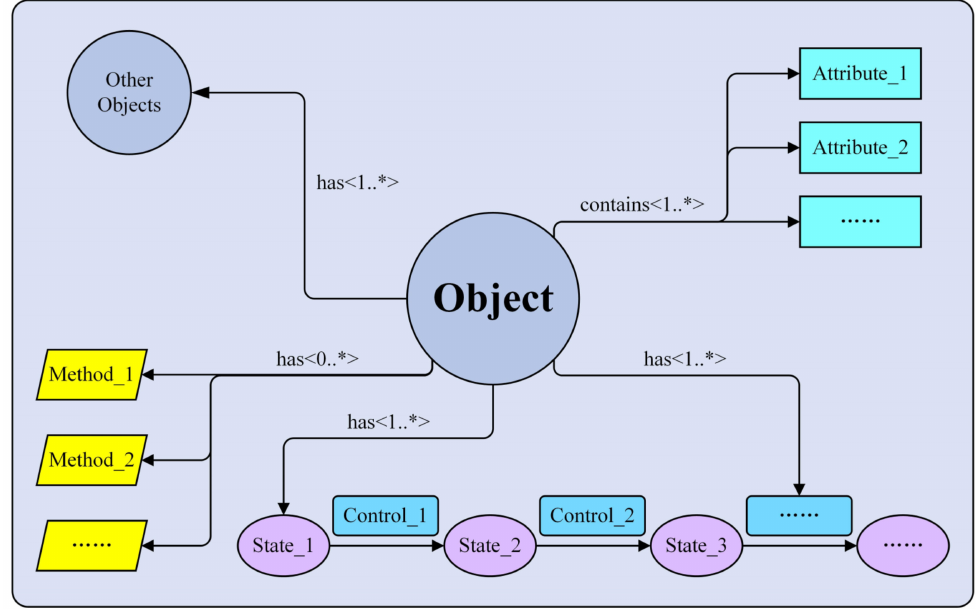
Figure 5. ILS Core unified data model framework. Asterisk symbol means many elements. It is a part of the symbol expressing 0..* (zero, one or many) or 1..* (one, or many) relationships in unified modeling language (UML). This explanation applies to all asterisks symbols that appear in this